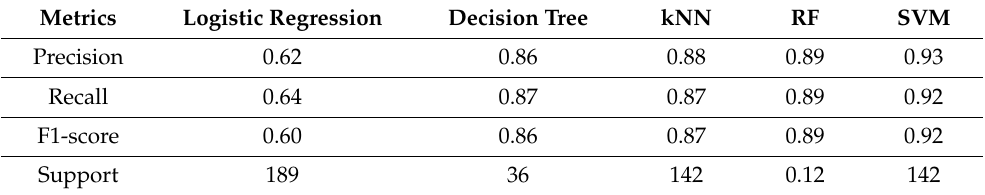
Table 2. Comparison of the classification models.